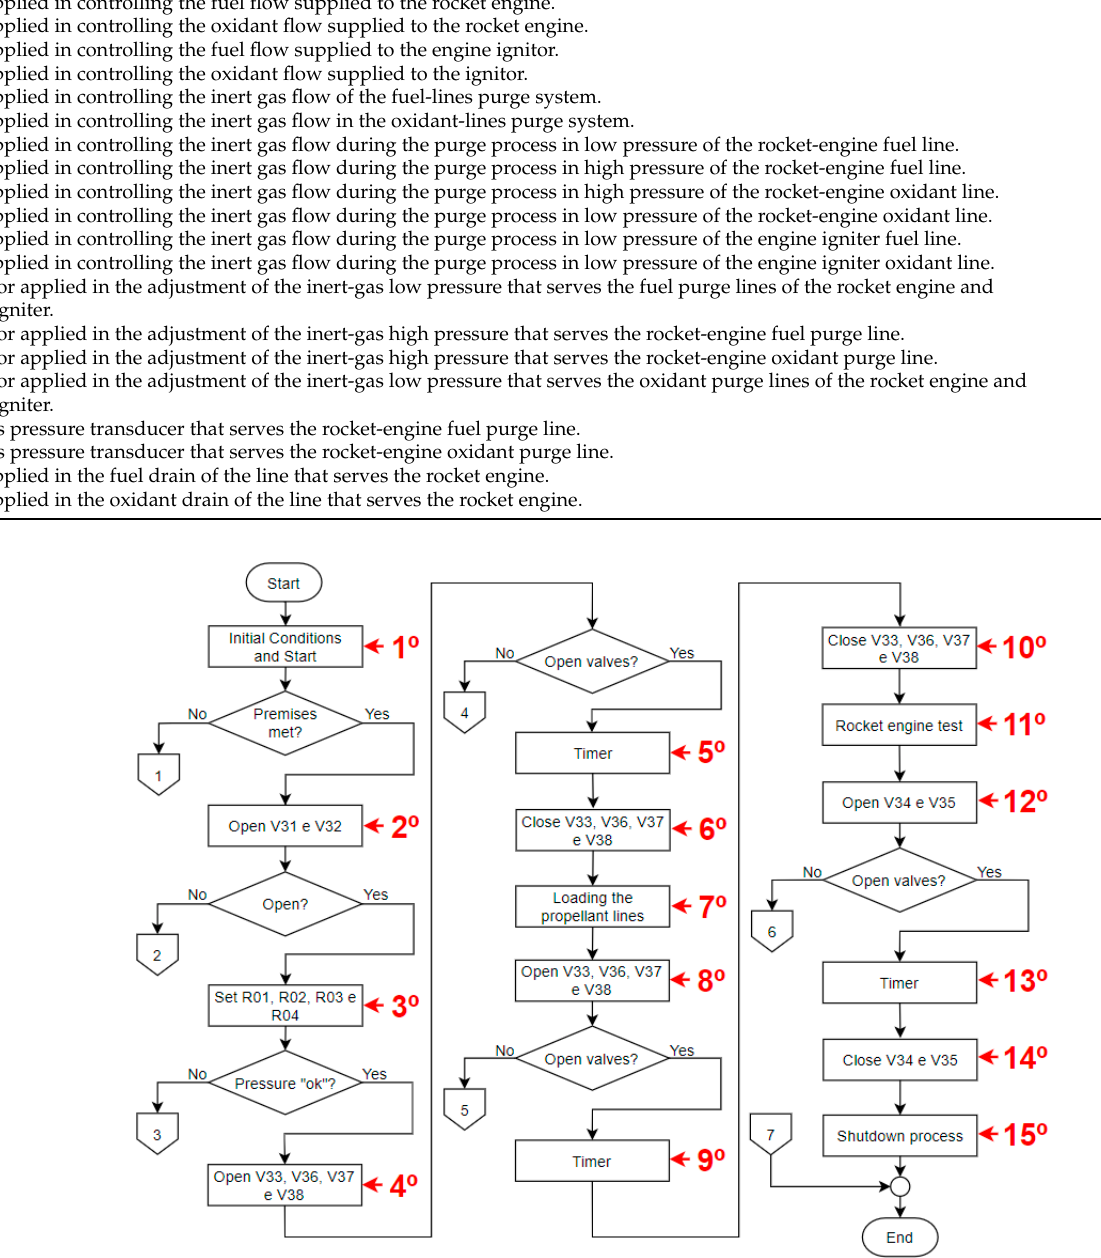
Table 2. Description a lgorithm blocks.